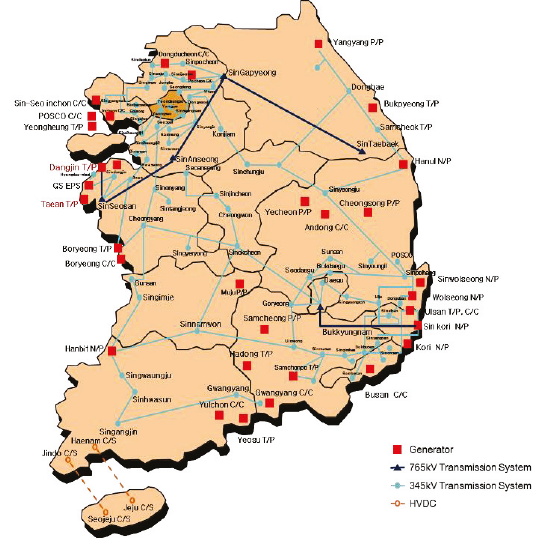
Figure 1. Overview of Korean power systems.